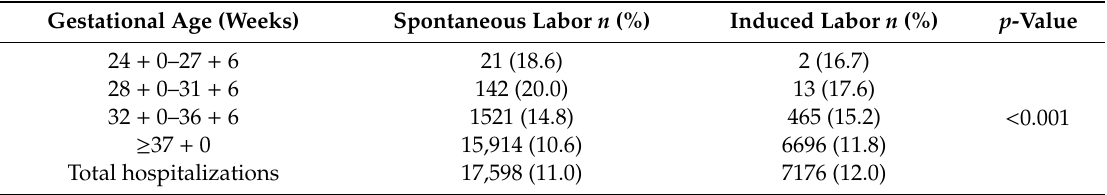
Table 4. Incidence of infectious-related hospitalizations of induced versus spontaneous deliveries stratified by severity of prematurity.